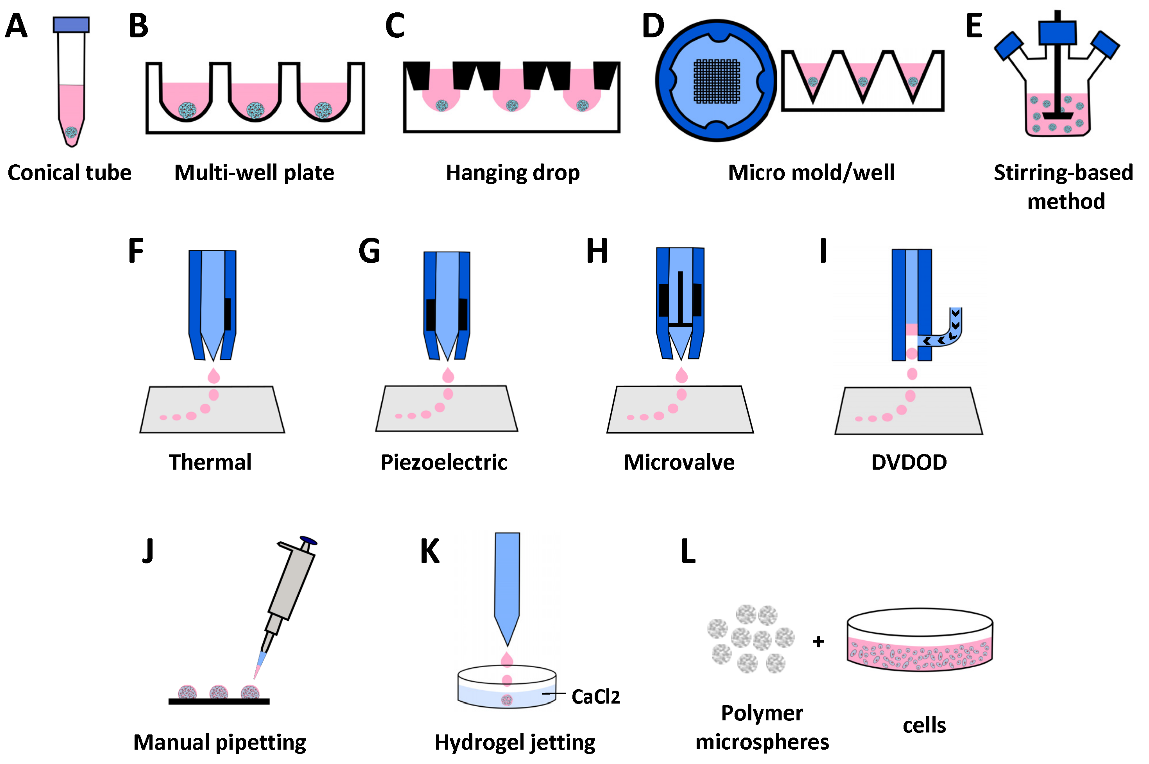
Figure 1. Illustration of common methods for generating spherical building blocks. ( A ) Conical tube or deep-well plates centrifugation. ( B ) Round bottom non-adhesion plate method. ( C ) Hanging drop method. ( D ) Micro-mold/well method. ( E ) Stirring-based method. ( F – I ) 3D droplet bioprinting methods: ( F ) Thermal actuation-based inking jet bioprinting. ( G ) Piezoelectric actuation-based ink- ing jet bioprinting. ( H ) Microvalve-based bioprinting. ( I ) Direct-volumetric drop-on-demand (DVDOD) bioprinting. ( J ) Manual pipetting. ( K ) Hydrogel jetting (for alginate microspheres). ( L ) Polymer microspheres.